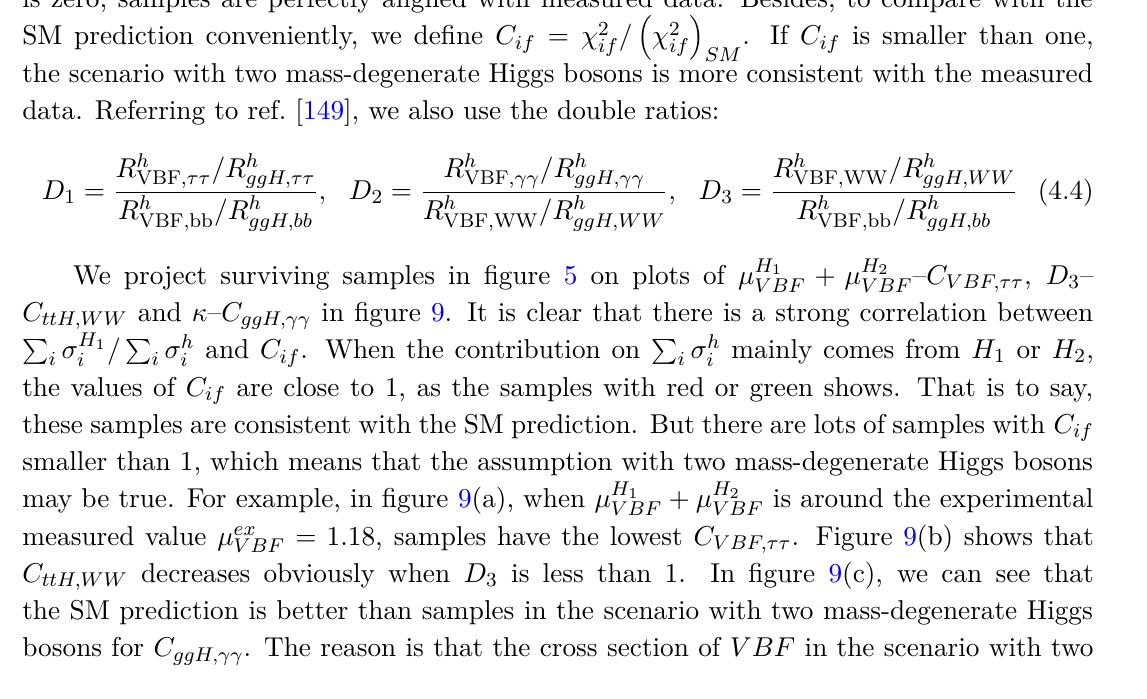
Figure 9 . All surviving samples in figure 5 are projected on plots µ H 1 C ttH,WW and κ – C ggH,γγ . The colorbar is the same as in figure 8.